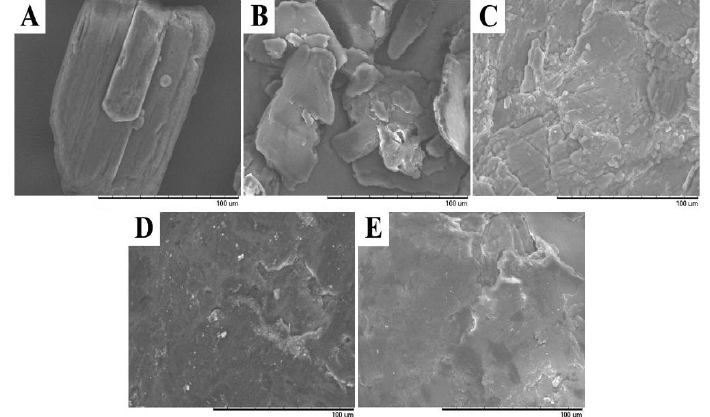
Figure 6. Scanning electron micrographs of A. Ibuprofen, B. Stearic acid, C. Compressed ibuprofen at 19.9kN, D. Compressed stearic acid at 19.9kN, and E. Compressed 4:6 weight ratio binary mixture of ibuprofen-stearic at 19.9kN.